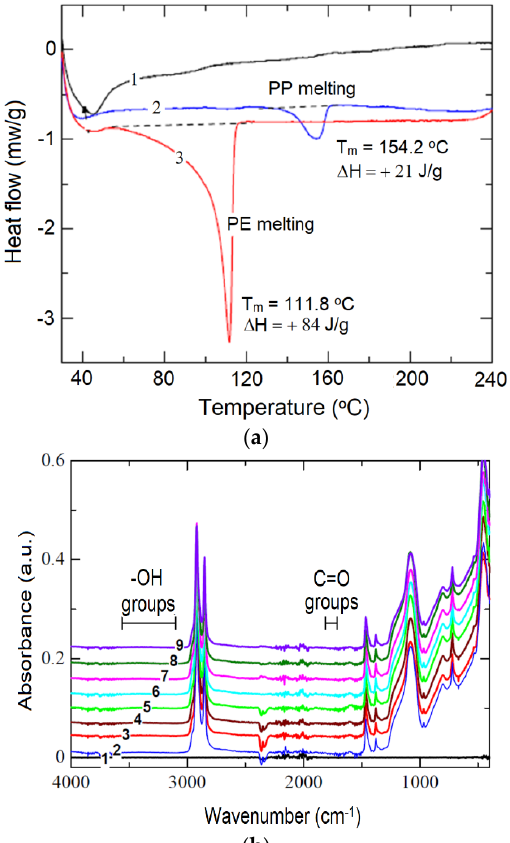
Figure 7. ( a ) Comparative non- isothermal DSC curves (β = 5 K/min., air): 1— EPR insulation; 2 — EPR sheath; 3 — LDPE insulation. ( b ) ATR/FTIR spectra of irradiated EPR insulation at different doses under different conditions: (1) — reference (ATR crystal); (2) − 0 kGy; (3) − 9.6 kGy (bulk-free ends); (4) − 28.8 kGy (bulk-free ends); (5) − 96 kGy (bulk-free ends); (6) − 310 kGy (bulk-free ends); (7) − 310 kGy (bulk-wax-encapsulated ends); (8) − 630 kGy (bulk-free ends); (9) − 630 kGy (bulk-wax-encapsu- lated ends).